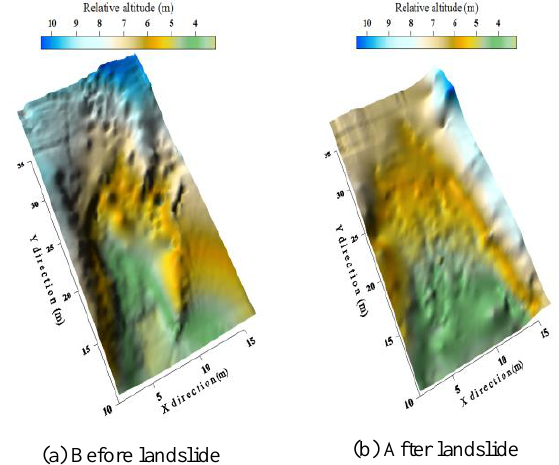
Figure 7. Construct the DTM at site B with close range photogrammetry (a) before landslide and (b) after